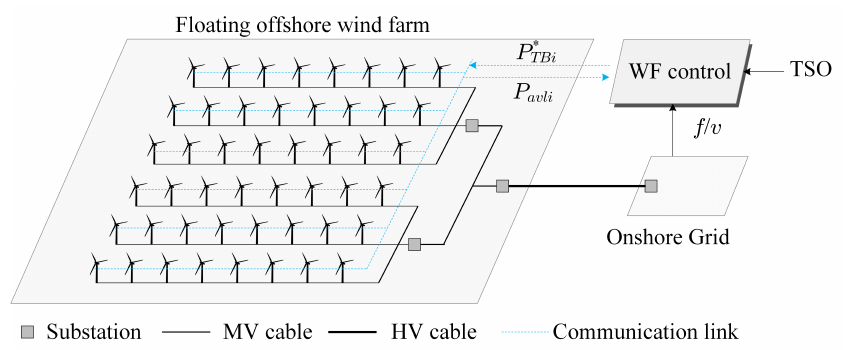
Figure 19. Offshore wind farm